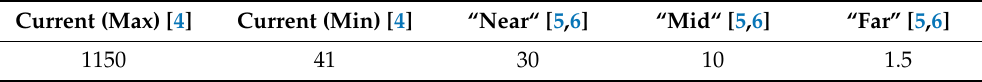
Table 1. Current and future expectations for Sail Assembly Loadings [4–6]. Data is given in g · m − 2